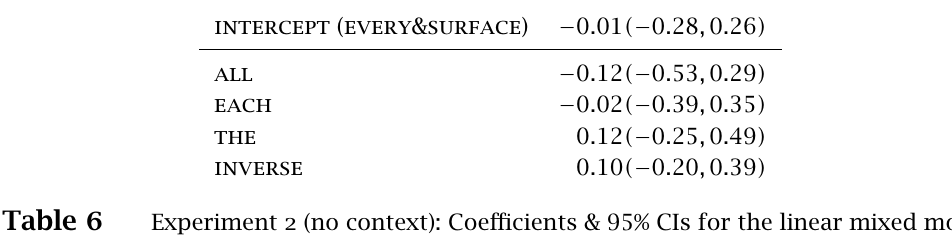
Experiment 2 (no context): Coefficients & 95 % CIs for the linear mixed model of the full-sentence (summed) residualized log